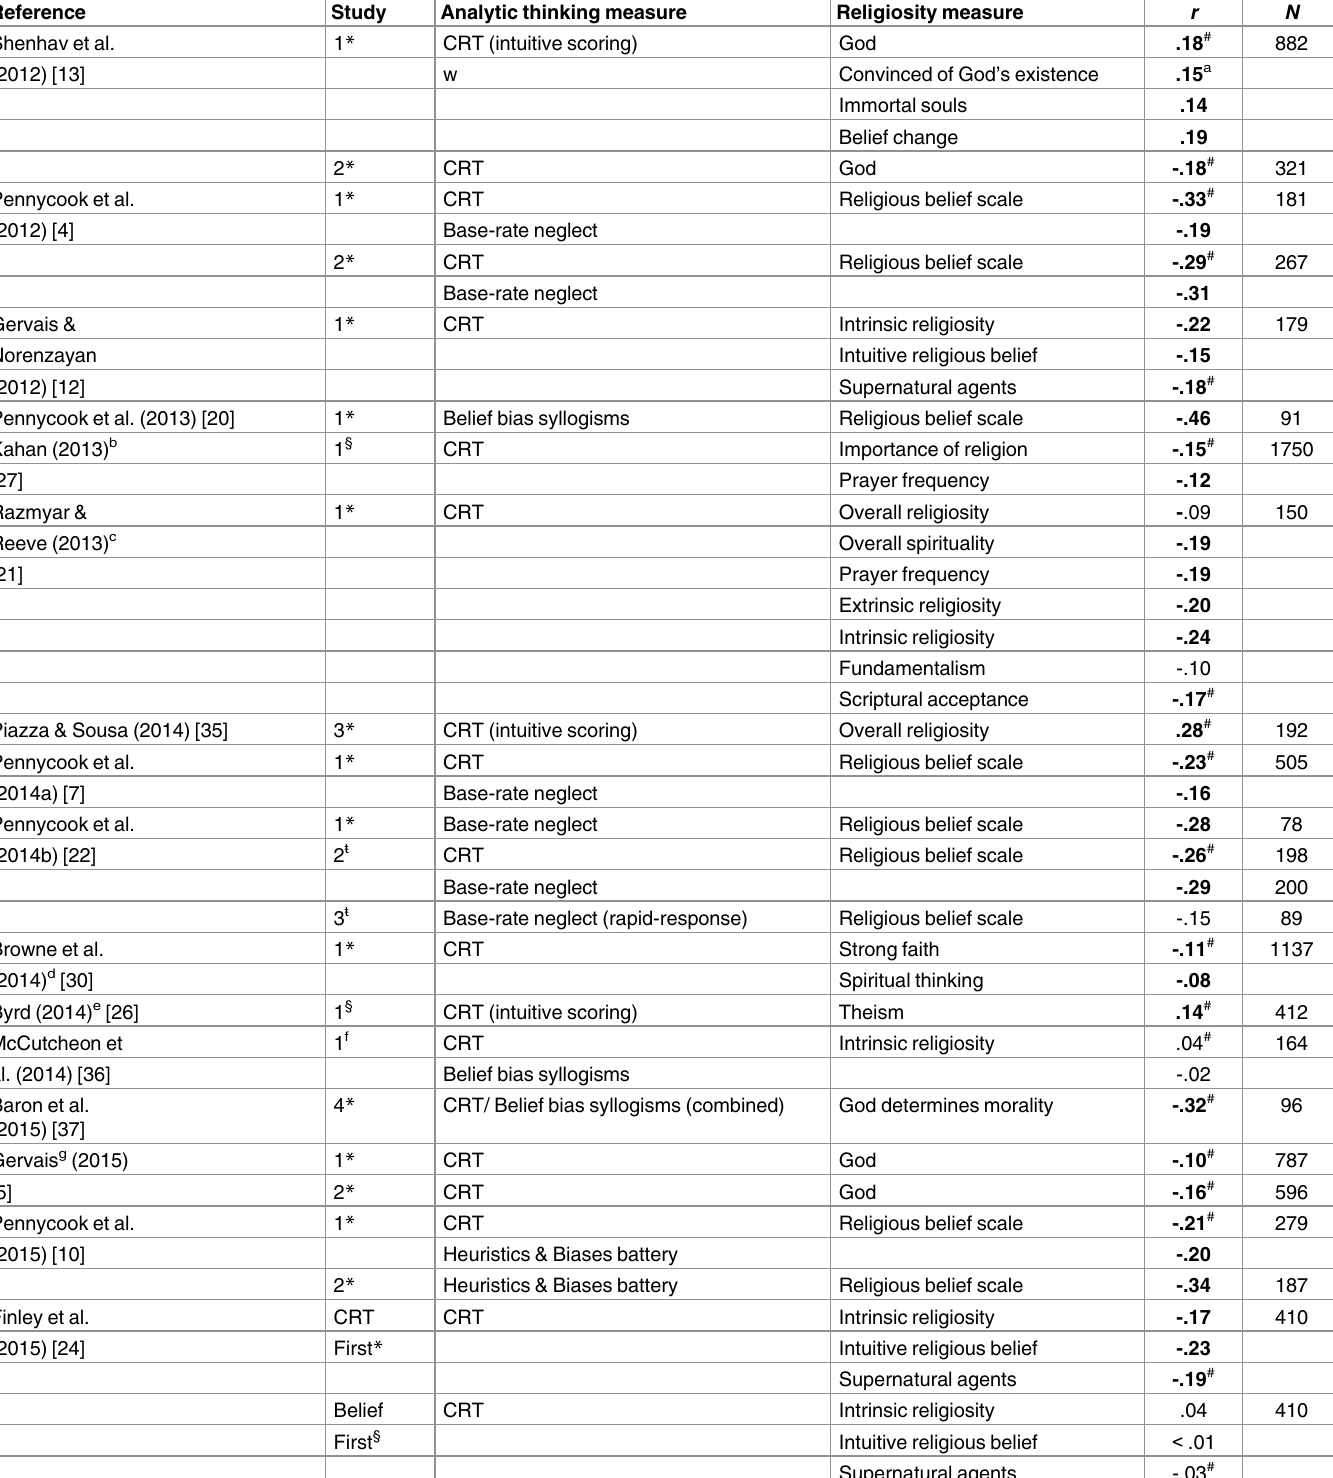
Table 6. Summaryof studies reporting a correlation ( r ) between a behavioral measureof analytic thinking and religiosity (variously measured). Significantcorrelationsare in bold.